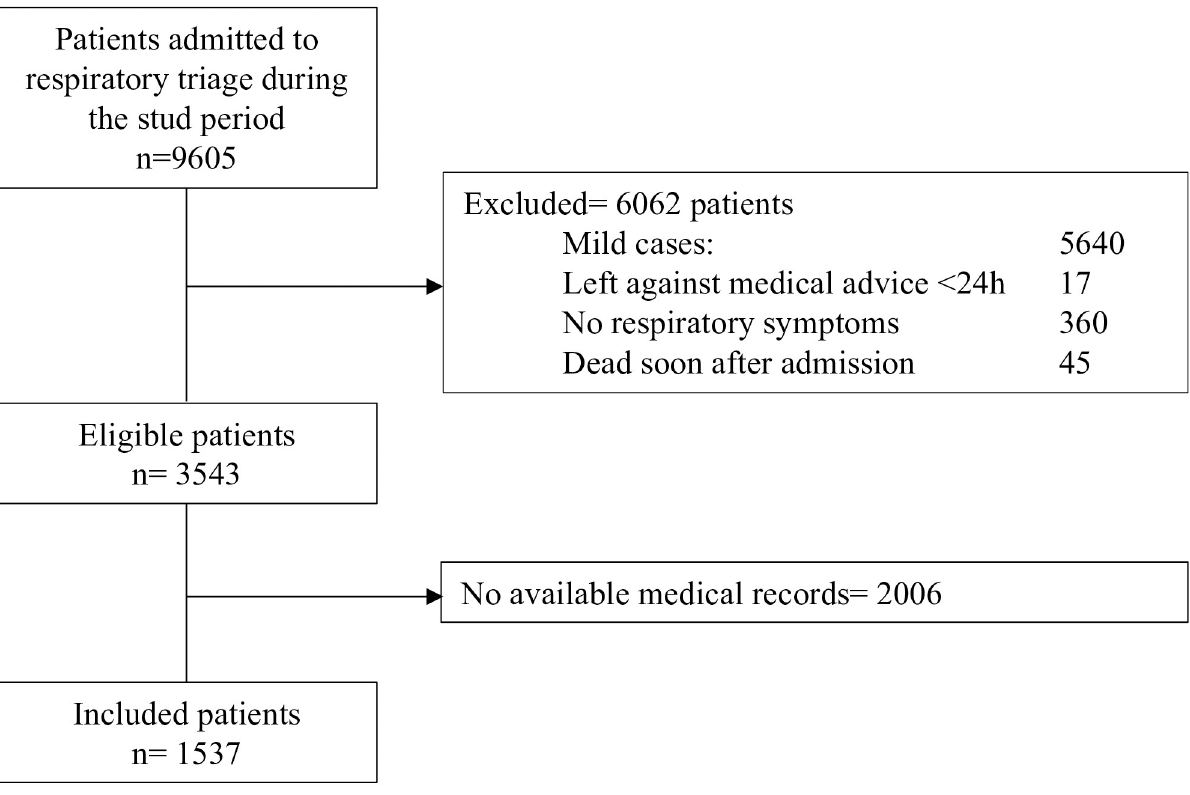
Fig 1. Flowchart of